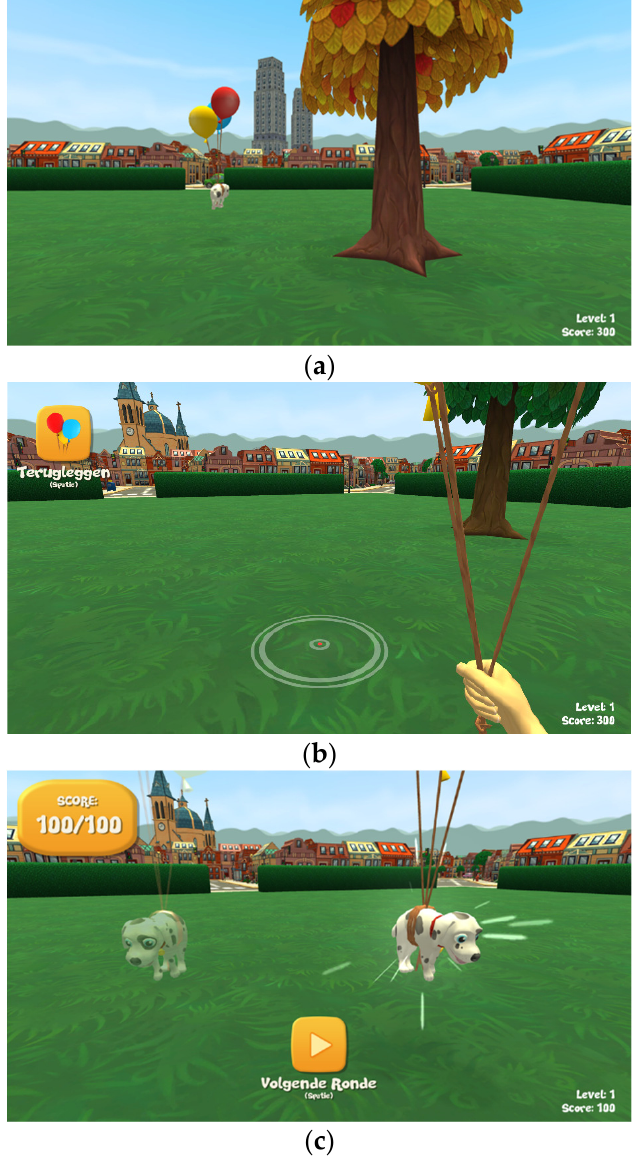
Figure 2. Example screenshots of the player’s view in the different phases of a trial in the spatial cognition game. ( a ) Encoding phase. The object is presented in the middle. Balloons were added to increase visibility from afar. One of the proximal cues (tree with orange leaves) is visible in the front, as well as one of the distal cues (skyscrapers) in the back. ( b ) Testing phase. Player is holding the object by the balloons. The balloon icon on the upper left indicates that the player should now replace the object. The grey circles on the ground and red dot in the middle indicate the exact position where the object is replaced if the space bar is pressed. One of the proximal cues (tree with green leaves) is visible near the player, and one of the distal cues (church) is visible in the back on the left side of the screen. ( c ) Feedback phase. Obtained points are presented on the upper left. The chosen location by the player is show in transparent, and the original location of the object is shown in solid, with surrounding flashing